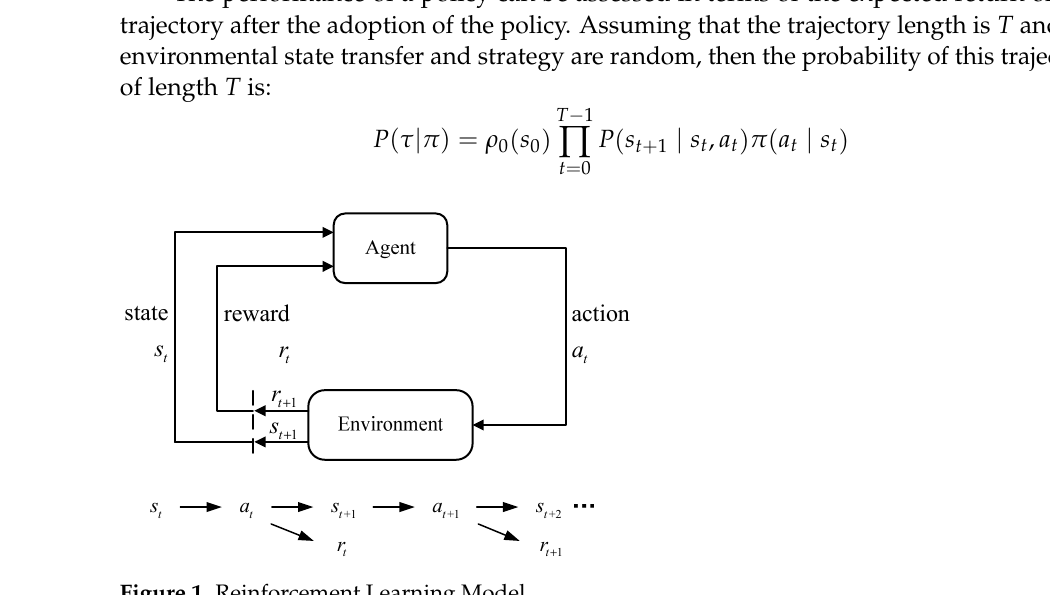
Figure 1. Reinforcement Learning Model.